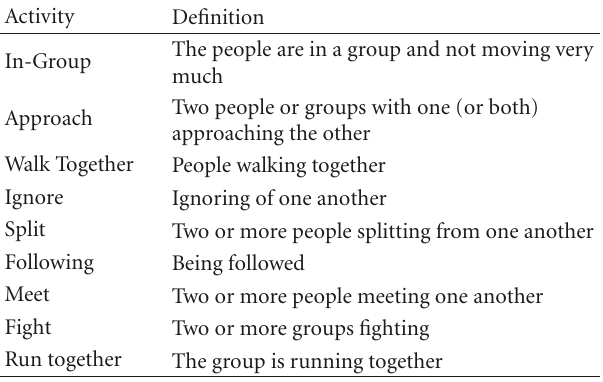
Table 4: The definition of nine activities in the BEHAVE